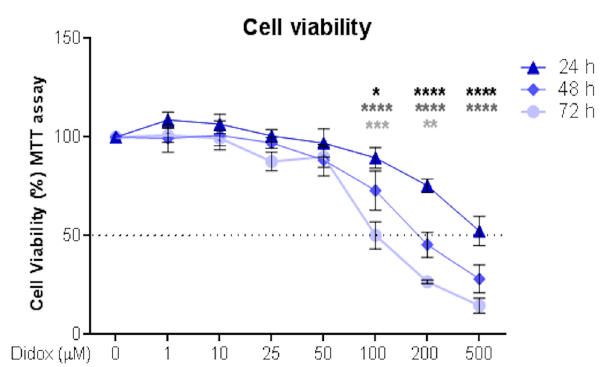
Figure 2. Didox reduced cell viability in HA22T/VGH cell line in time and a dose-dependent manner. HA22T/VGH were treated with 0, 1, 10, 25, 50, 100, 200 and 500 µM of didox for 24 (triangle, blue line), 48 (diamond, blue-sky line) and 72 (circle, light blue line) hours. An MTT assay was performed to verify cell viability after treatment. The values are expressed as % of viable cells over the not treated cells (0) at the indicated time point. The black dot line is drawn in correspondence to the half maximal inhibitory dose (IC 50 ). The graph represents the means of three independent experiments ( N = 3) with three internal values for each experiment. The black stars correspond to the comparison between 24 and 48 h; the grey stars between 24 and 72 h and the light grey stars between 48 and 72 h. * p < 0.05; ** p < 0.01; *** p < 0.001; **** p < 0.0001.